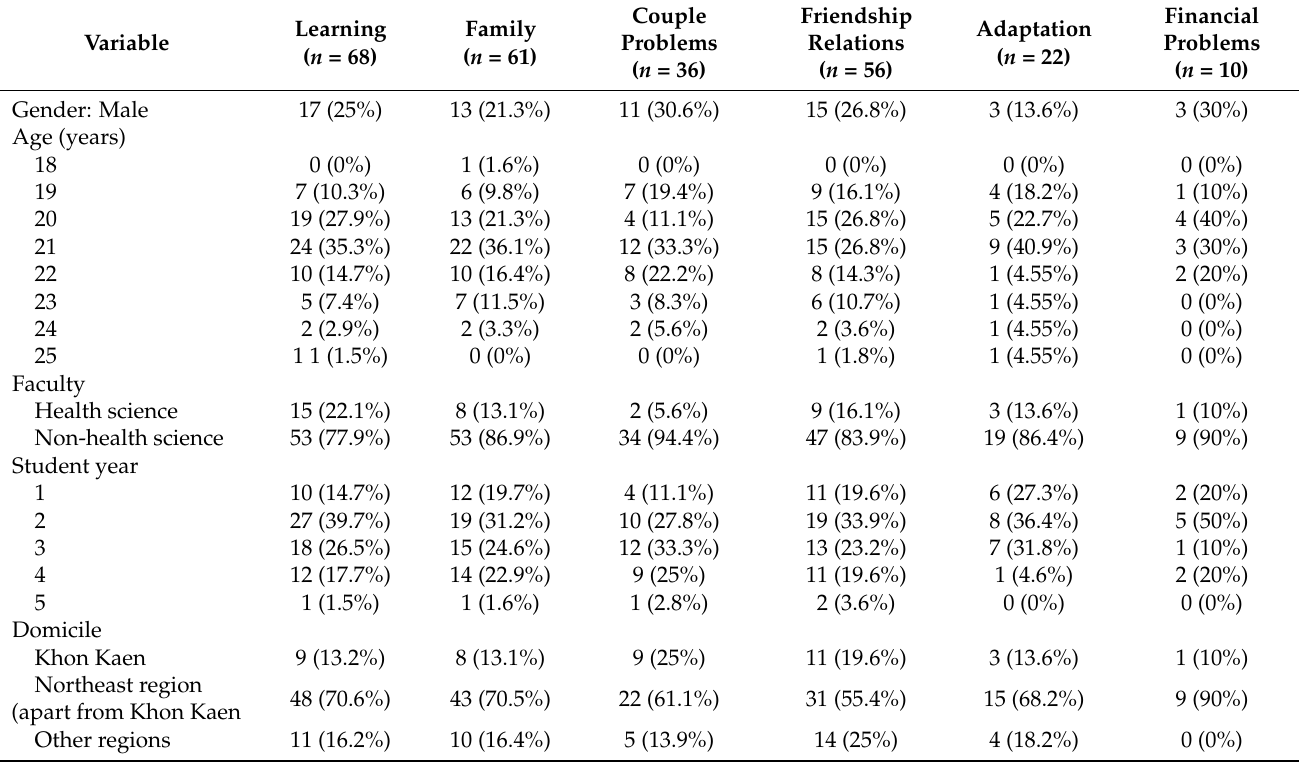
Table 2. Demographic data according to the problems of the